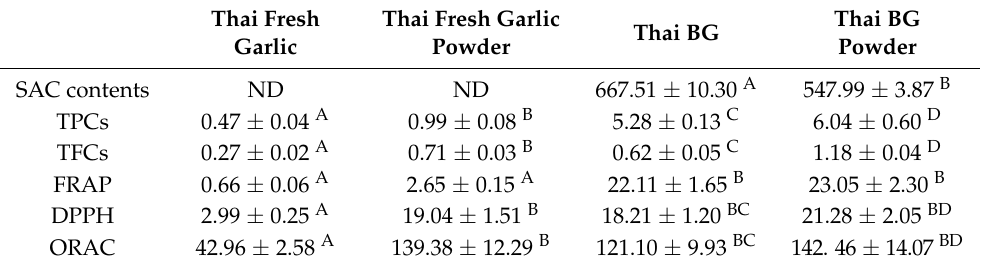
Table 4. Comparative SAC content, total polyphenols, total flavonoids, antioxidant activities of Thai strain garlic (fresh garlic, Thai BG and their powders) fermented in large scale chamber at 70 ◦ C, 80% RH in 12 days. Thai Fresh Thai Fresh Garlic Thai BG Thai BG Garlic Powder Powder SAC contents